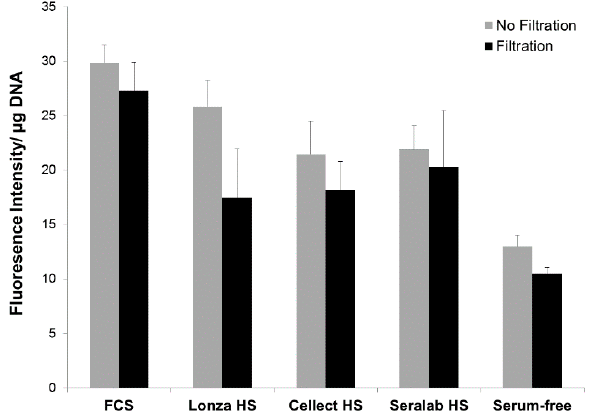
Figure A1. Metabolic activity measured in MSCs cultured for five days in SC medium supplemented with FCS or HS sera, with (black) or without (grey) filtration.